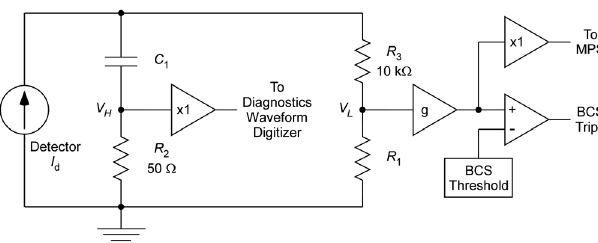
FIG. 10. Front-end circuit showing the input integrator and splitter. The diagnostics waveform is used only with the